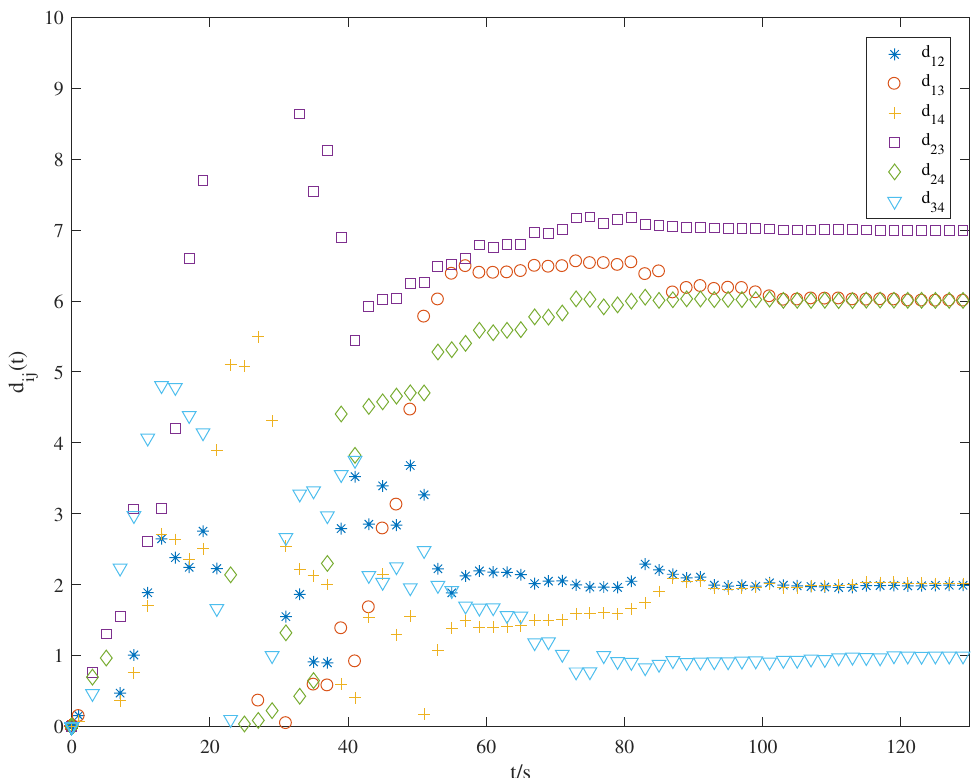
Figure 3. Topology structure of the dynamical network in Example 2.